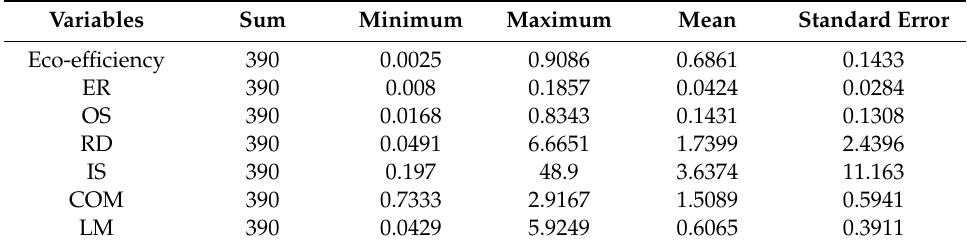
Table 3. Summary statistical for